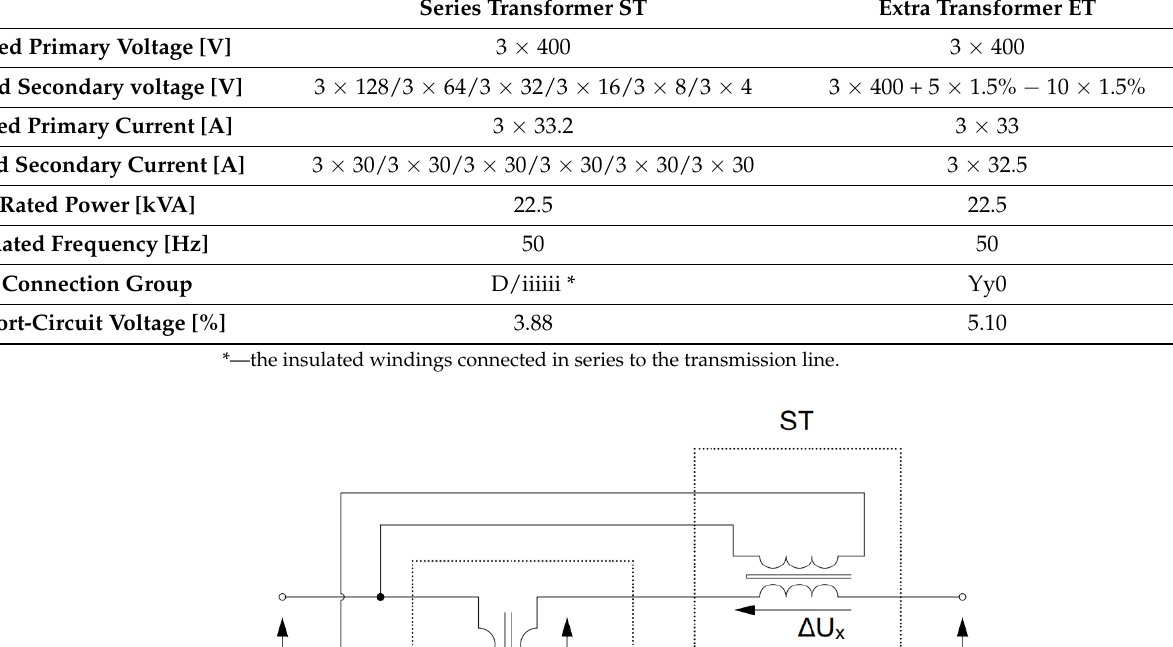
Table 1. Transformers’ data.